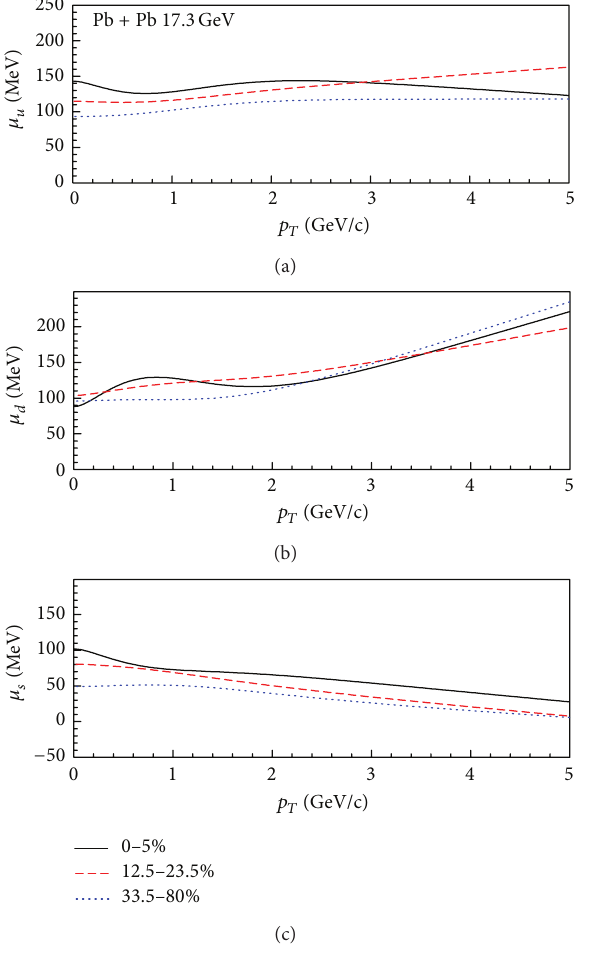
Figure 3: The same as that for Figure 2, but showing the results according to the dashed curves in Figure